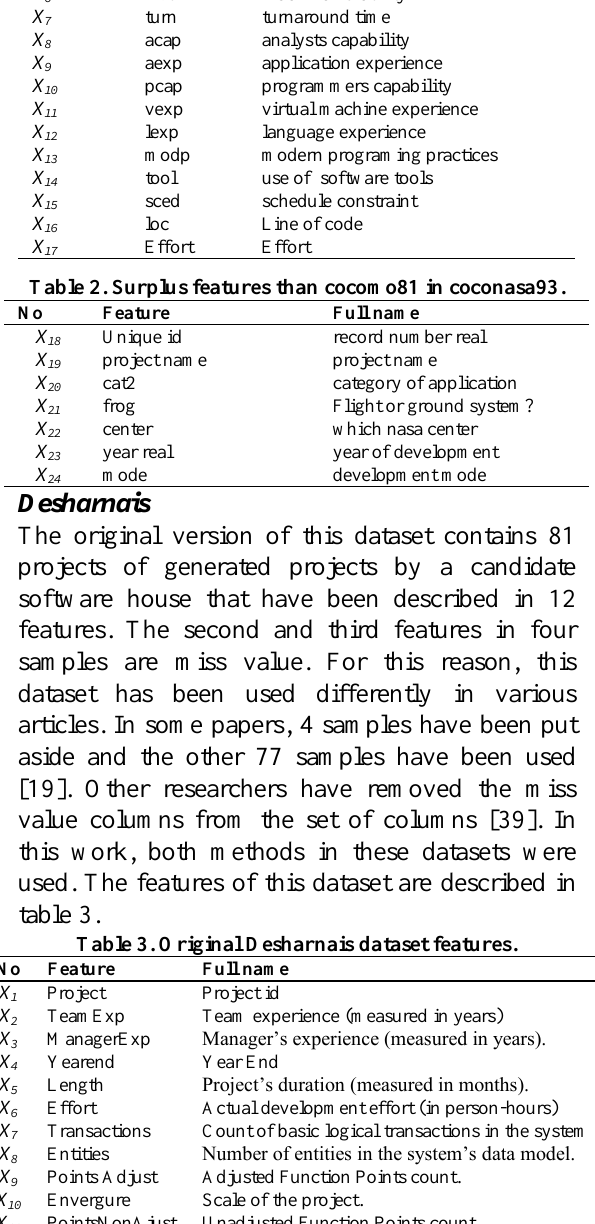
Table 1. Cocomo81 dataset features.